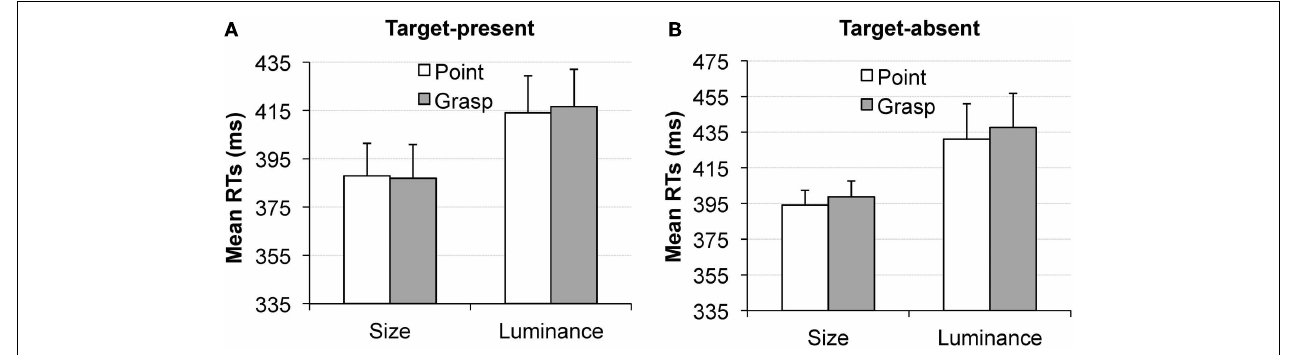
dimension are depicted on the left of (A,B) and for the luminance dimension [ (A,B) right]. Error bars represent standard errors adjusted to within-subject designs, calculated according to the procedure described in Cousineau